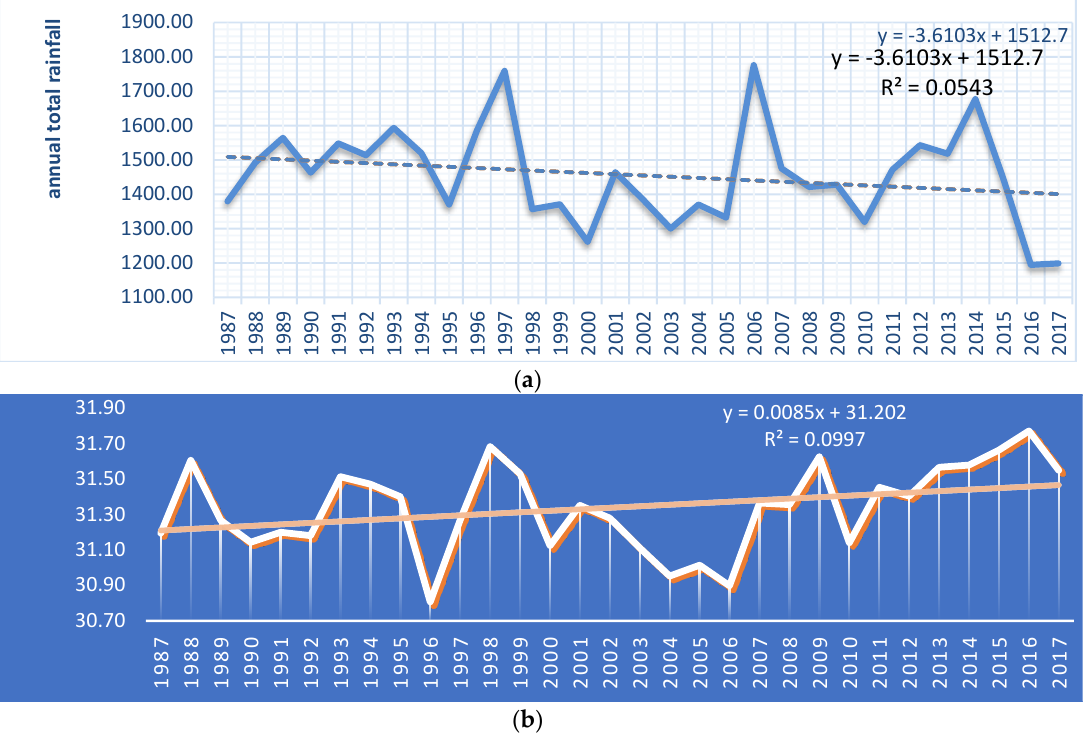
Figure 3. ( a ) Annual rainfall trend, source: researcher’s computation from meteorological data; ( b ) annual maximum temperature trend, source: researcher’s computation from meteorological data.